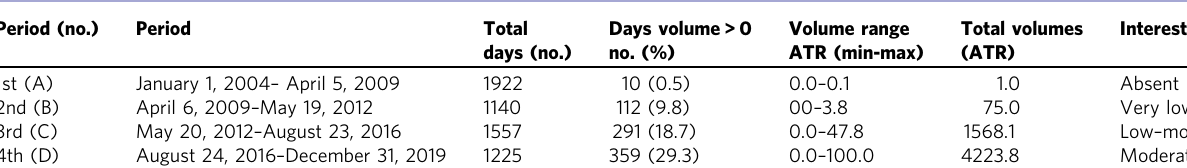
Table 1 Main statistical data about the period analysed. Period (no.)